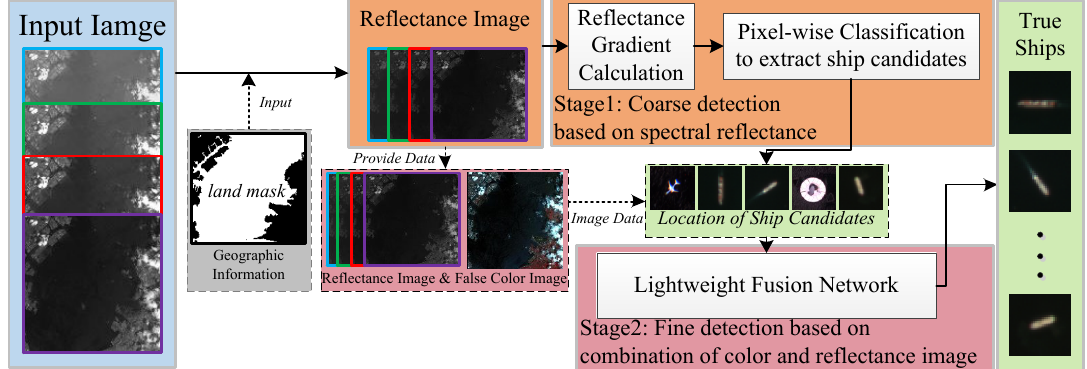
Figure 2. The flowchart of the proposed method: When considering a multispectral image, we use geographic information to obtain the ocean regions. Afterward, a coarse detection stage is performed, where the spectral reflectance image is computed based on the ocean image. This procedure is then followed by the calculation of the reflectance gradient across different bands for each pixel. The pixels are classified according to the designed features. The classification result enables us to obtain the ship candidate location. In the fine detection stage, we use the lightweight fusion network to further verify the ship candidates. After this step, the final ship-detection results are